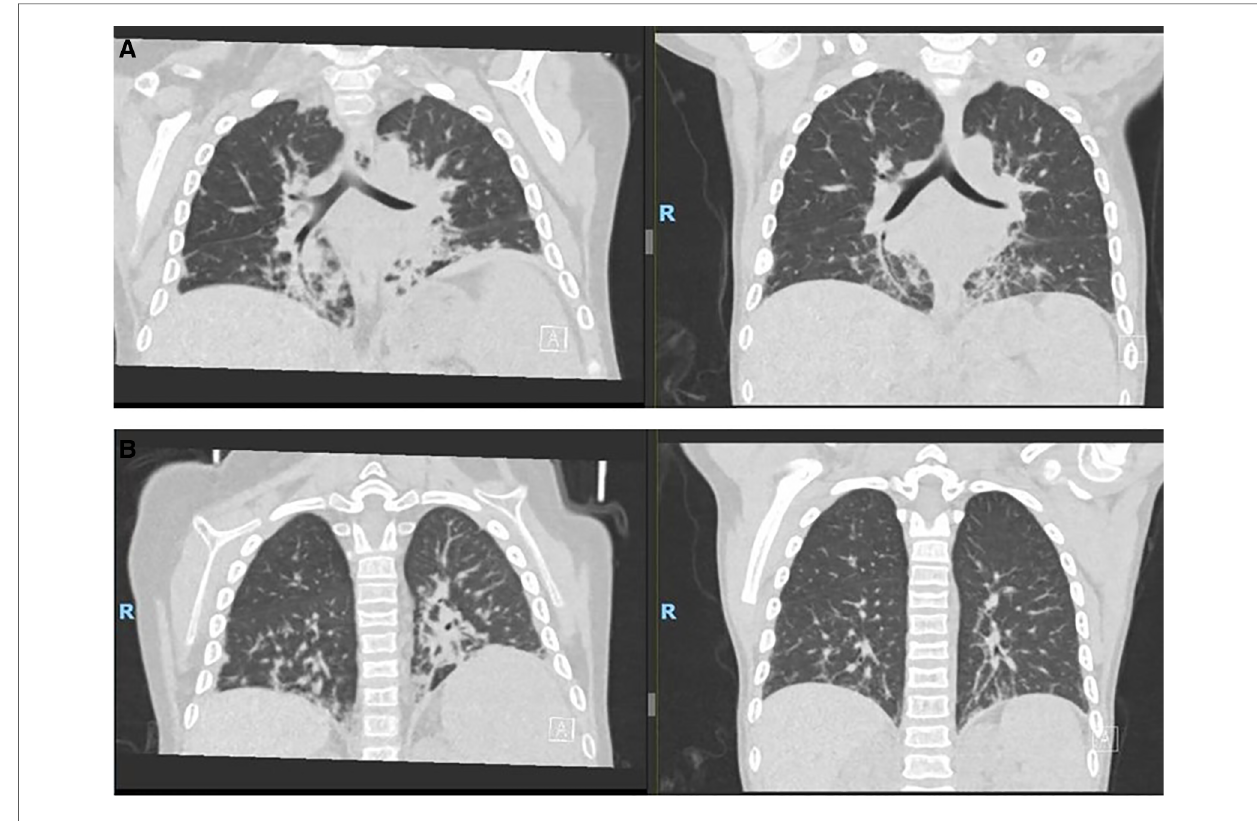
FIGURE 2 Ct scans. ( A ) Pre – allo-HSCT. ( B ) 9 months post – allo-HSCT. CT, computed tomography; allo-HSCT, allogeneic hematopoietic stem cell